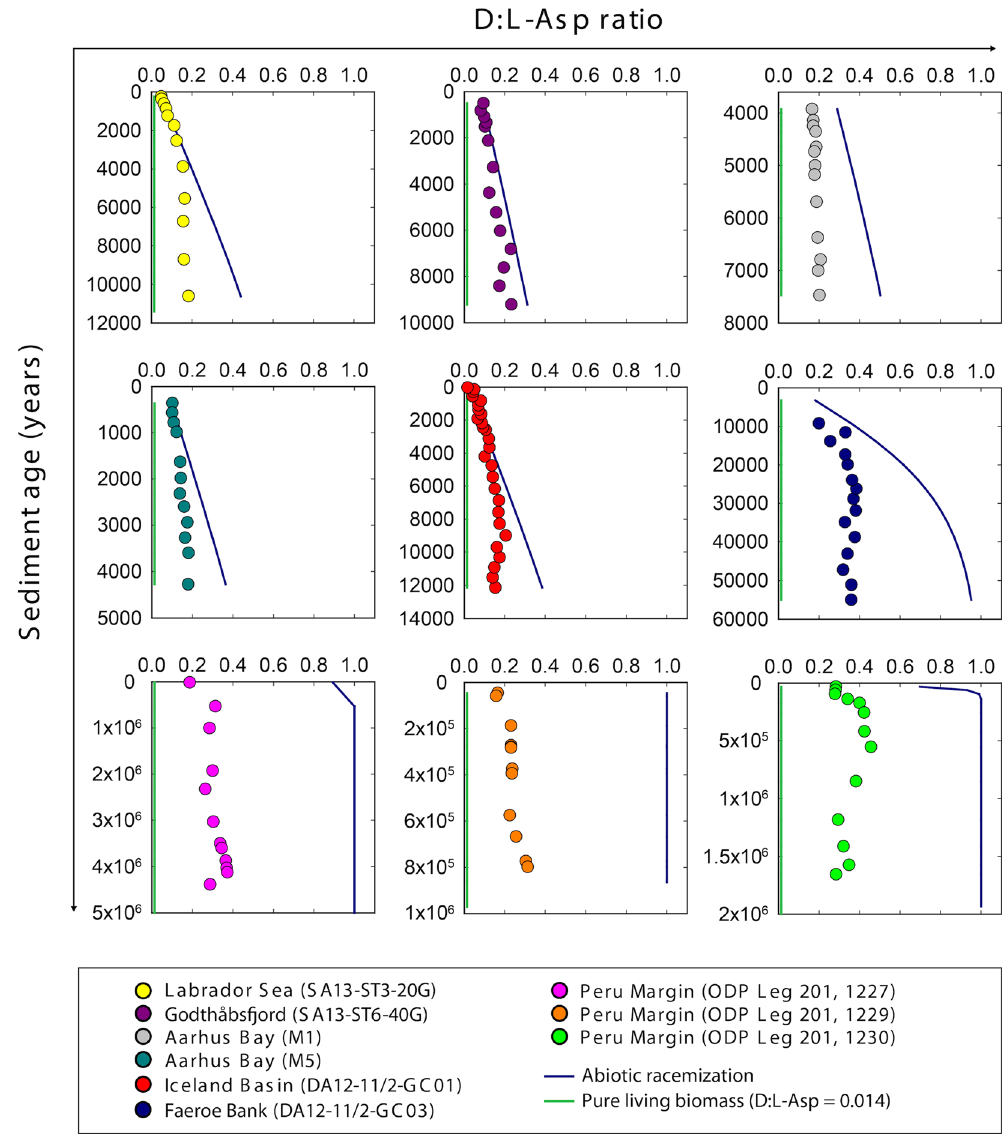
Figure 5. Balance between abiotic racemization and biological turnover of Asp. Ratios of D:L-Asp in the sediment (colored circles) are higher than that of pure vegetative cell biomass (green lines, D:L-Asp ratio = 0.014) 15 , but lower than those predicted from pure chemical racemization (blue lines) 12, 13 . In very old sediments ( > 10 5 years), D:L-Asp ratios are between 0.3 and 0.4, whereas pure racemization would have led to a ratio of